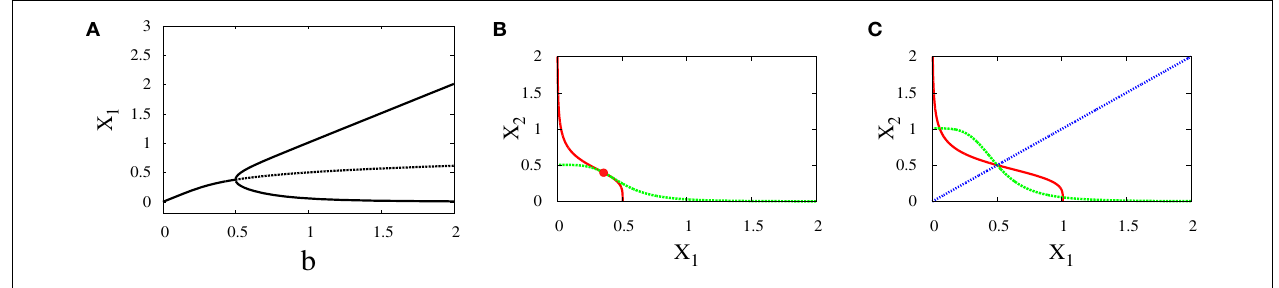
FIGURE 4 | Supercritical pitchfork bifurcation diagrams for symmetric scenario . Bifurcation diagram (A) and nullclines at the beginning (B) and end (C) of the bifurcation. For all diagrams, n = 4, r = 0.5, a 1 = a 2 = 0.01, k 1 = k 2 = 1.The solid lines indicate stability, while dashed lines indicate unstable branches.